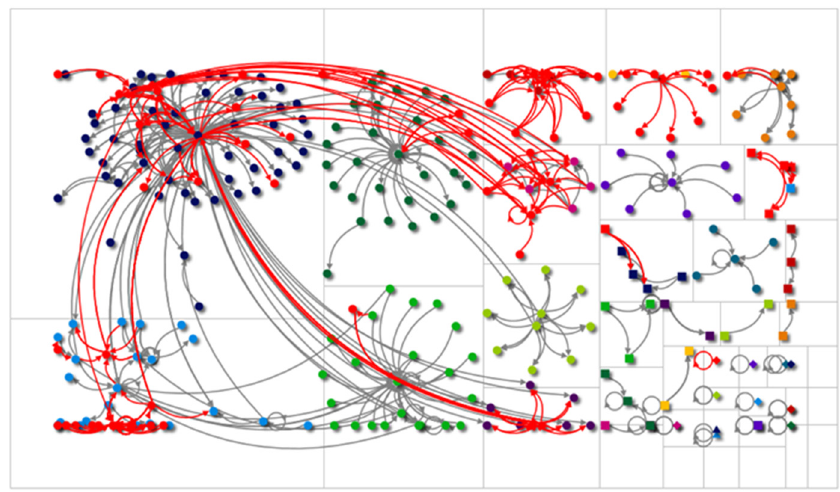
Figure 1. Representation of the colostomy network. The observed colors represent the different user groups that were identified in the network analysis. Furthermore, the red circles represent nurses present on the network. Red arrows represent communication with other users.